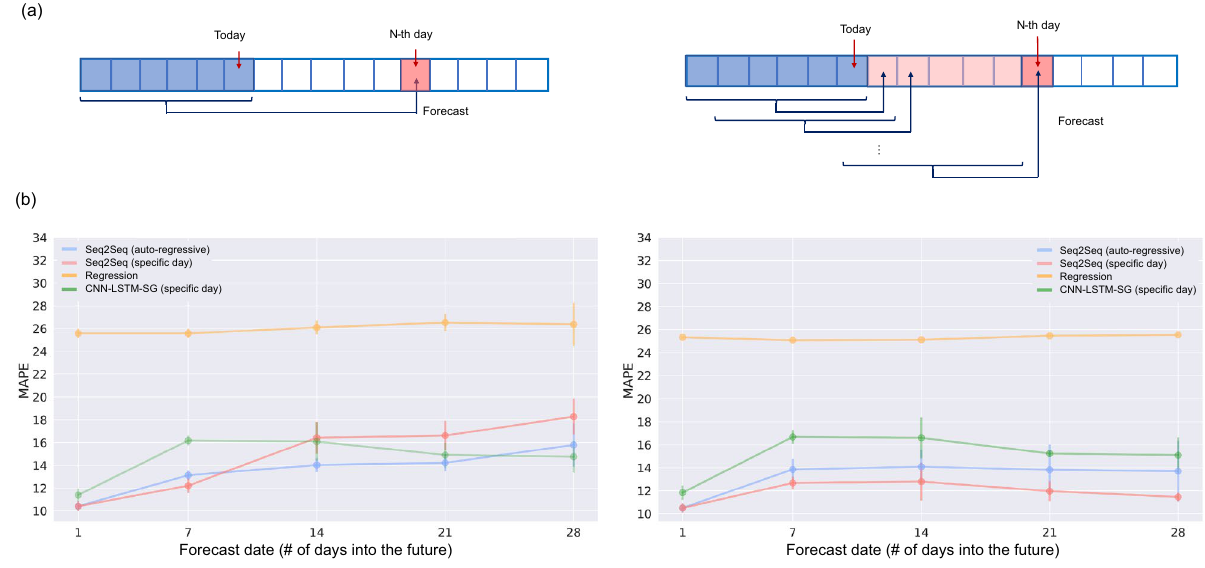
Figure 5. Long-term antipsoriatic irradiance forecasting. Results on Nakhon Pathom dataset were shown. ( a ) Diagram of two approaches for making long-term forecast: developing specific artificial neural network model for making forecast for a specific day that is a certain number of days into the future (left) and autoregressively using the next-day forecast as input for making forecast for the day after that (right). ( b ) Long-term antipsoriatic irradiance forecasting performance for up to 28 days into the future on the validation set (UV data from 2018) and the test set (UV data from 2019). Performance for SurfUVNet, the regression model based on Earth–Sun distance and total ozone column, and the best CNN-LSTM models were